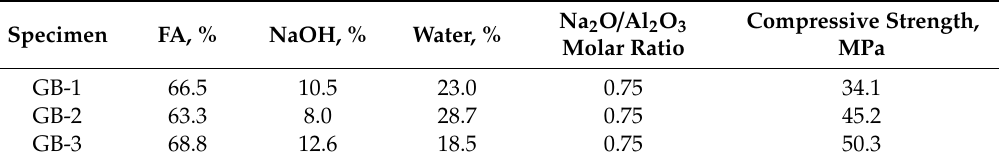
Table 3. Mix design and compressive strength of fly ash-based alkali-activated